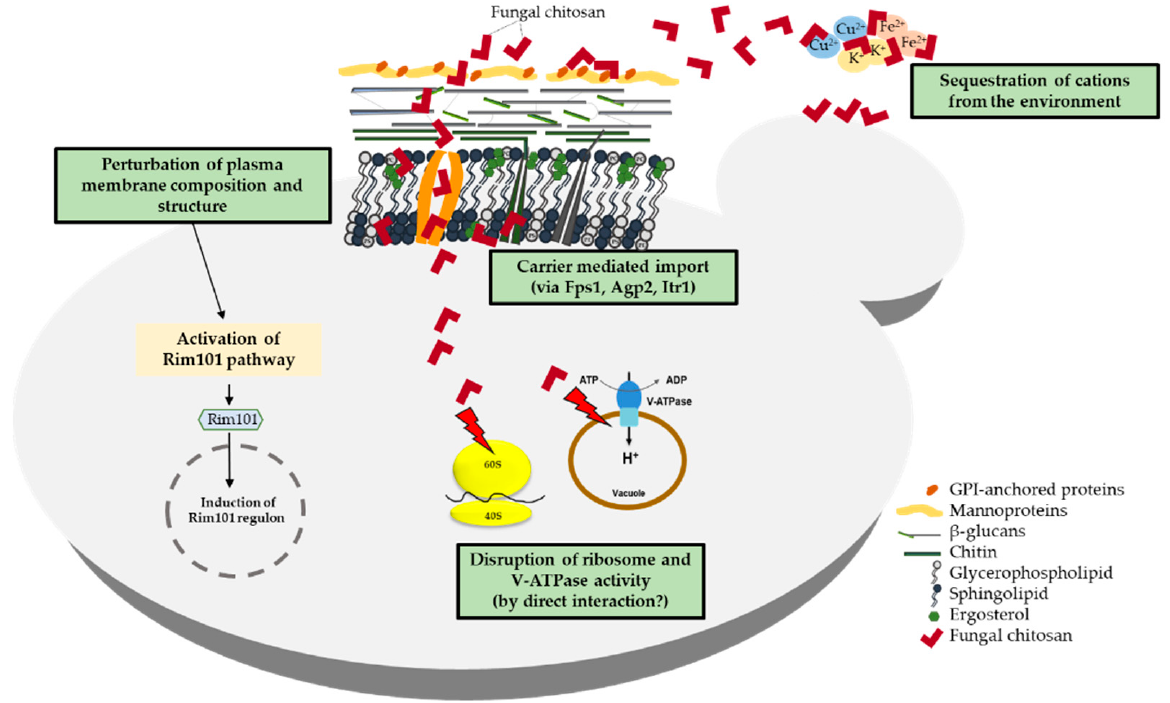
Figure 6. Schematic model for the adaptive response of S. cerevisiae to chitosan-induced stress according to genome-wide phenotyping analysis results, as detailed in the text. Abbreviations: phosphatidylcholine (PC), phosphatidylserine (PS), phosphatidylethanolamine (PE). Supplementary Materials: The following supporting information can be downloaded at https://www.mdpi.com/xxx/s1: Figure S1: Phenotypic profiling of chitosan No Brett Inside ® of a set of commercially available strains for wine fermentation, as revealed by spot assays. Figure S2: Phenotypic profiling to SO 2 of a set of commercially available strains for wine fermentation, as revealed by spot assay. Figure S3: Growth curves of three commercial S. cerevisiae strains (K7, UCD595, and AWRIR2) and the laboratory strain BY4741 and four spoilage yeast ( Dekkera anomala IGC5152, Pichia anomala UTAD37, Saccharomycodes ludwigii UTAD17, and Zygosaccharomyces bailii UTAD265) in MMB media (at pH 3.5) at different chitosan concentrations (0.25, 0.5 and 1 g/L); Figure S4: Comparison of the susceptibility to chitosan No Brett Inside ® of the Saccharomyces cerevisiae BY4741 parental strain with spot assay, at the indicated concentrations of chitosan in MMB (pH 3.5) agarized medium; Figure S5: Illustrative example of deletion strains exhibiting different susceptibility profiles in the chemogenomics screenings carried out. Figure S6: Venn diagram comparing genes that were found to confer resistance to SO 2 with those that were found to confer resistance to chitosan No Brett inside ®